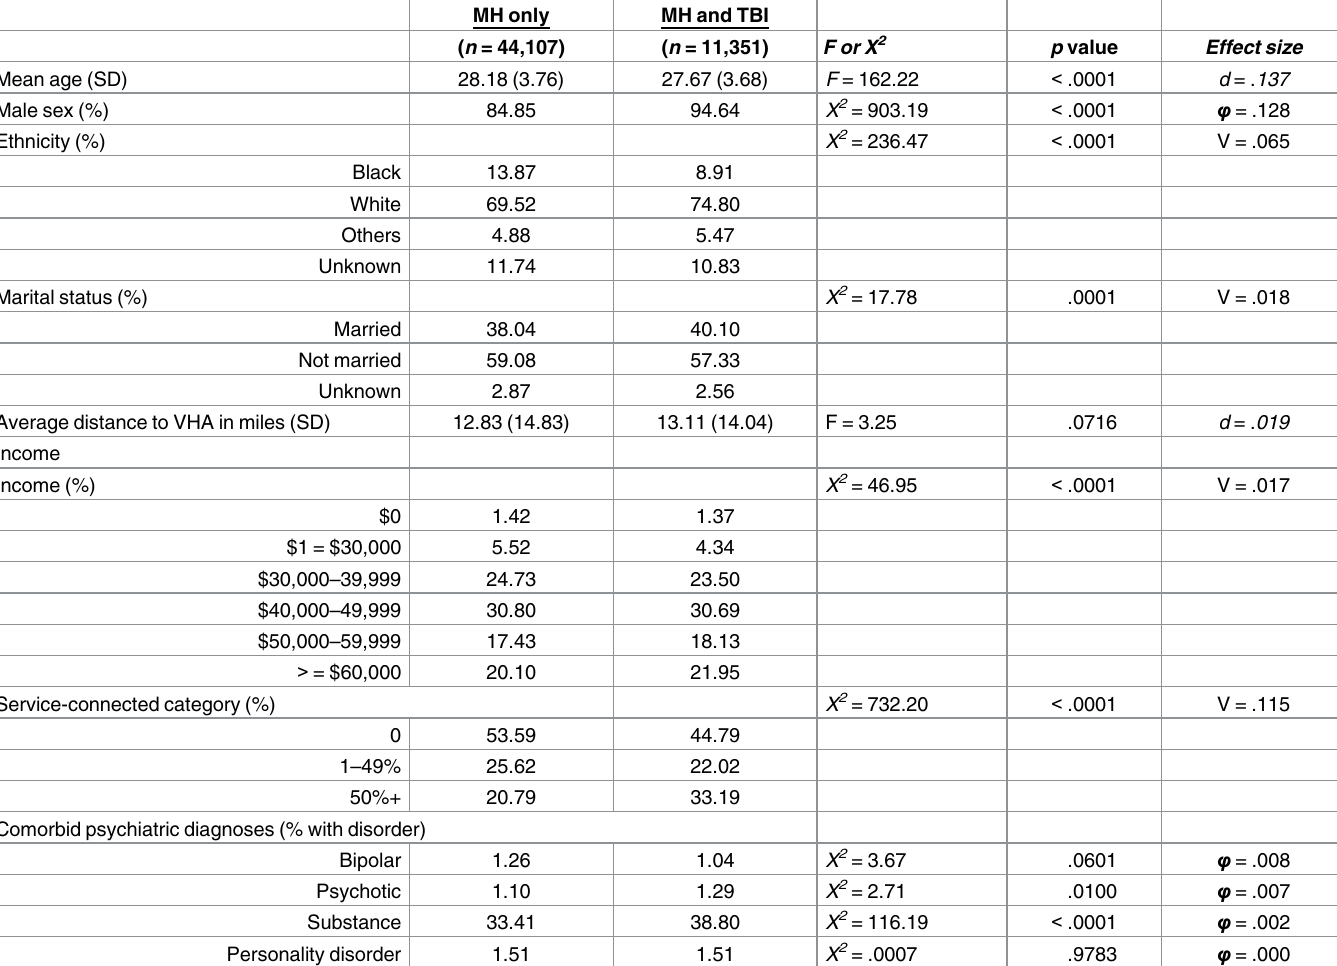
Table 1. Demographics of OEF/OIF veterans with new MH diagnoses, with and without TBI histories (N =